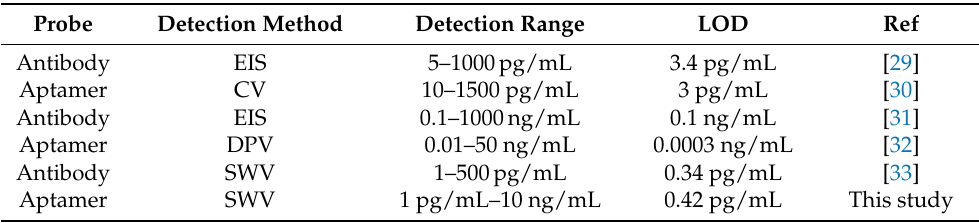
Table 2. Comparison of electrochemical biosensors for IFN- γ detection reported in the literature and the electrochemical biosensor proposed in this